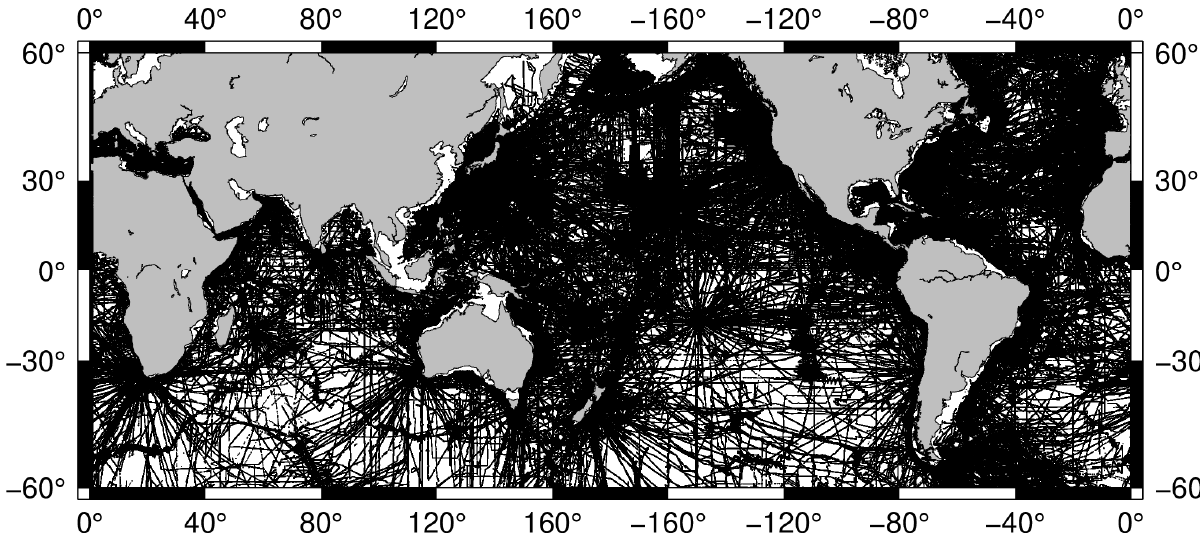
Figure 2. Distribution of ship survey routes.